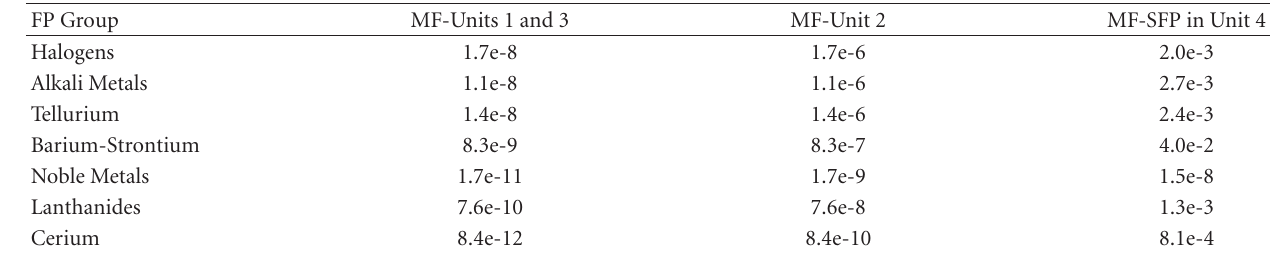
Table 8: The MFs related to the assumptions (1) to